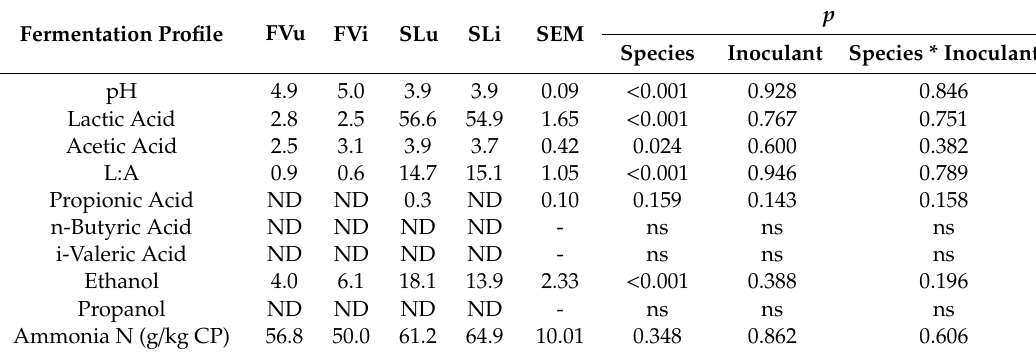
Table 2. Fermentation characteristics of the seaweed silages, treated with (FVi, SLI) and without (FVu, SLu) a Lactobacillus plantarum inoculant, after 90 days ( n = 3) (g / kg DM unless stated otherwise).